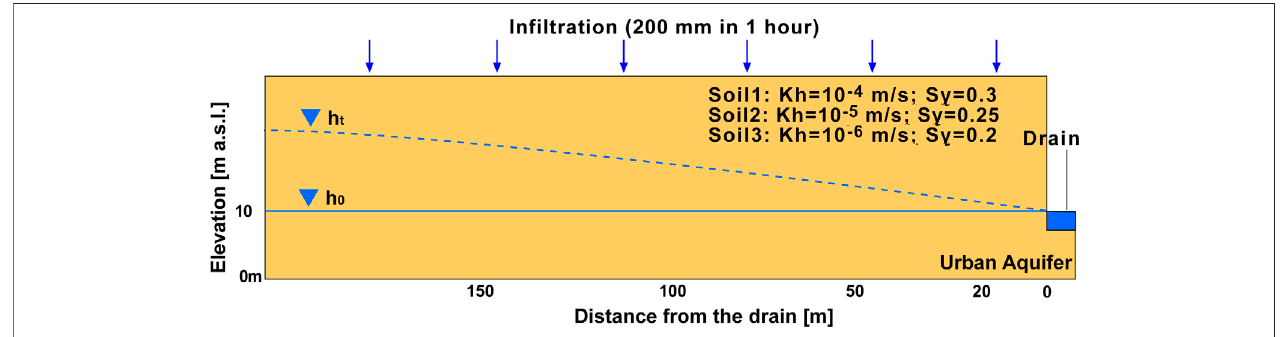
FIGURE 3 | Schematic of the numerical model; h0 indicates the water table in steady-state conditions, ht the water table during the